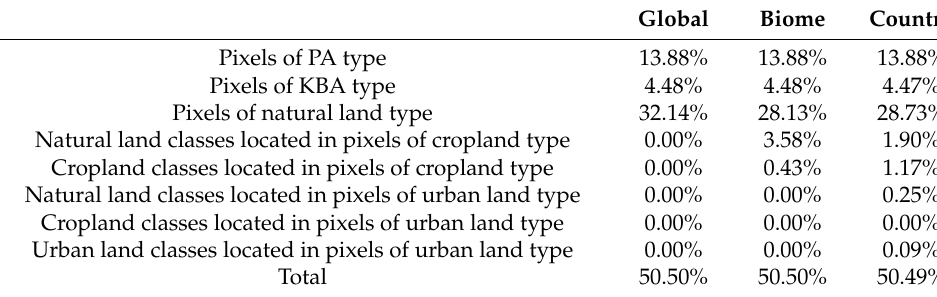
Table 4. 2050 shared: percentage of conserved area to global terrestrial area.